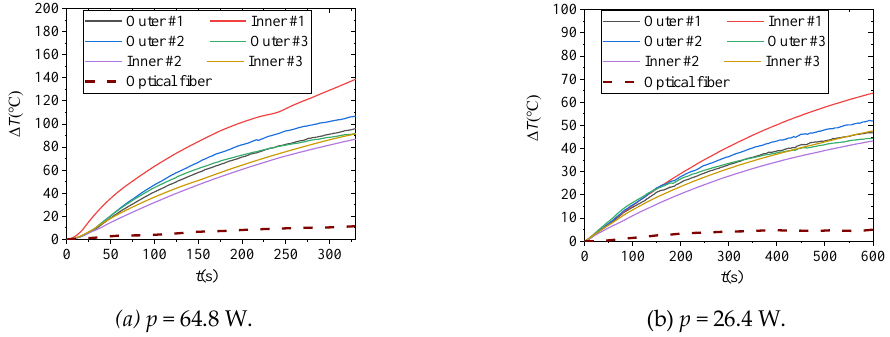
Figure 15. The results of temperature measurement. (Here, the temperature measurement values of thermocouples and the DTS under different heating power are present).